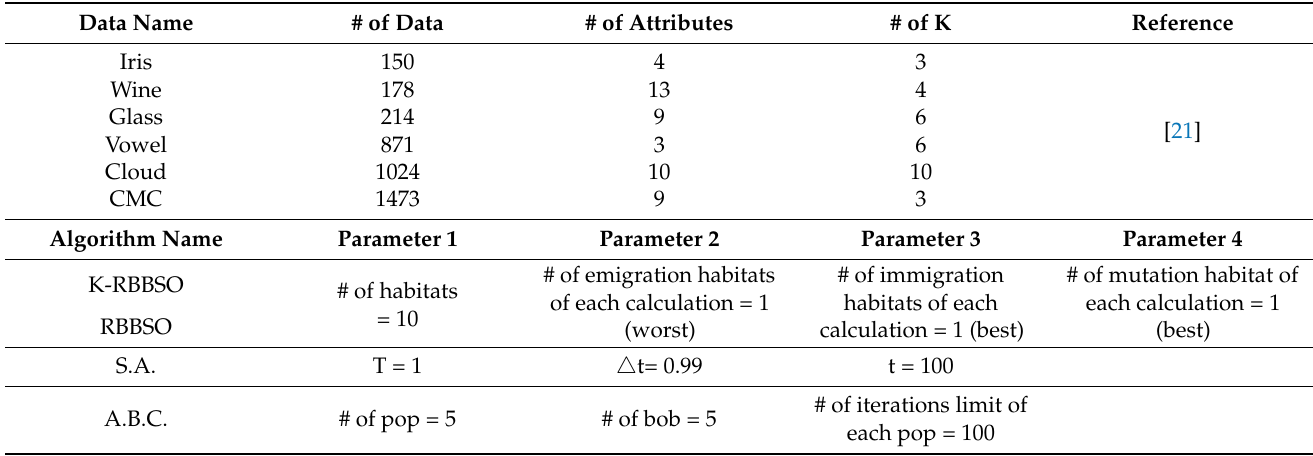
Figure 1. UCI Machine Learning Repository Home Page. Table 1. Data and algorithm parameter description.